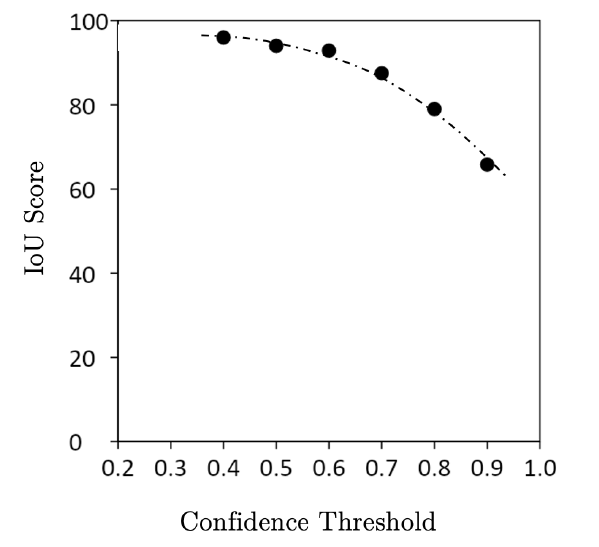
Figure 9. The variation of IoU score with confidence cutoff/threshold.